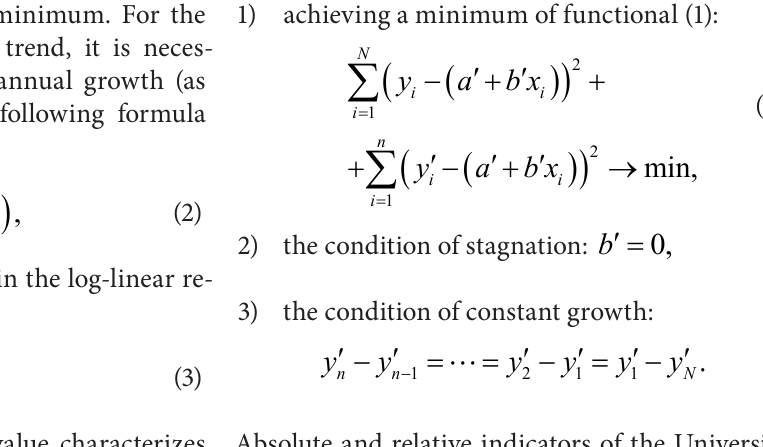
Table 1. Average data on funding of the University Financing, UAH mln Exchange rate of Years